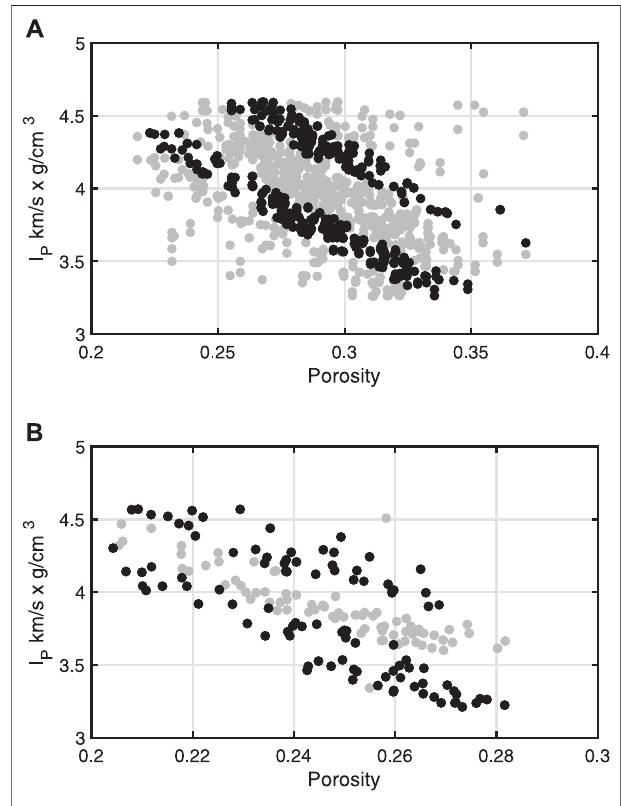
FIGURE 4 | (A) Portions of the oil sand data (black points) used in analysesone and two. The lowerset corresponds (216 points) toanalysis one and the upper (155 points) to analysis two. For the gas sand data (B) , the lower set of black points (127 points) corresponds to analysis three and the upper (75 points) to analysis